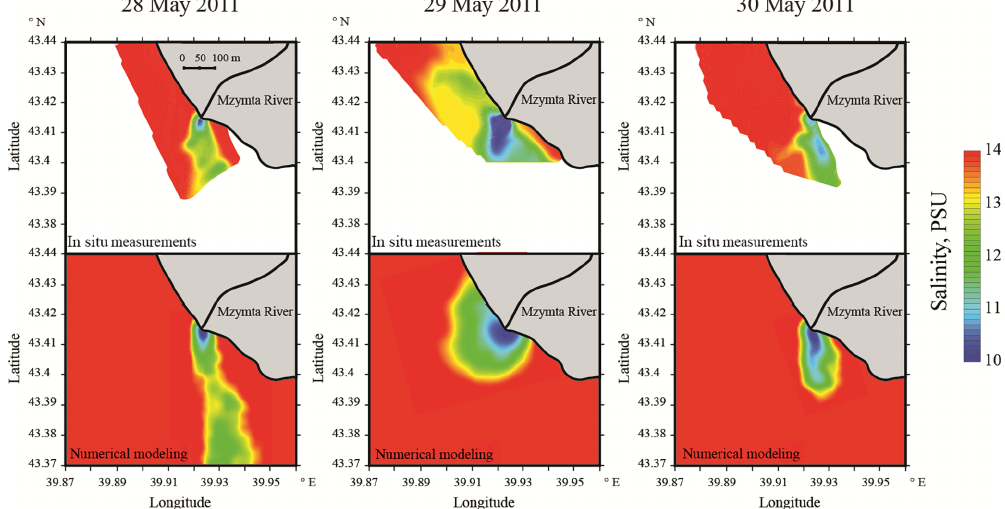
Figure 8. Measured (top panel) and modeled (bottom panel) surface salinity distributions near the Mzymta River estuary on 28–30 May